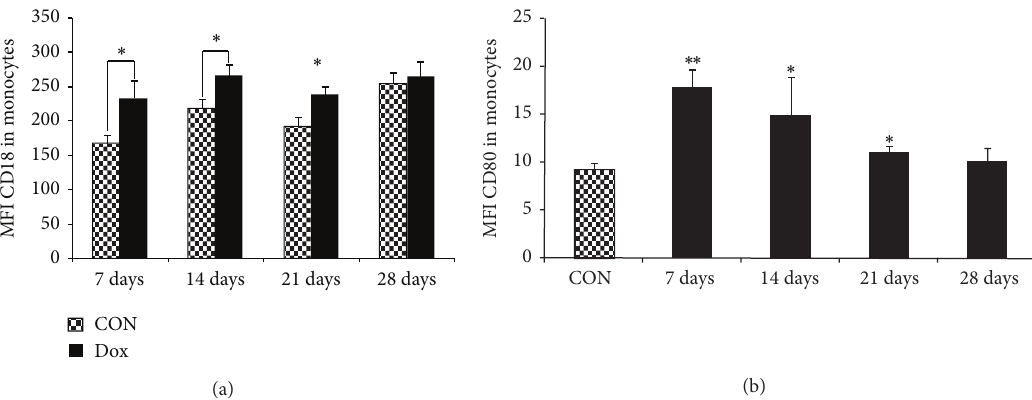
Figure 3: CD18 and CD80 expression in total monocytes from rats with nephrotic syndrome induced by doxorubicin and control animals in ex vivo condition. Blood leukocytesfrom rats ( 𝑛 = 32 ) that received a single dose of doxorubicin in tail vein (7.5mg/kg) and control rats ( 𝑛 = 32 ) that received PBS in the same condition were stained ex vivo for CD18 and CD80 expression. Data were collected using flow cytometry and analyzed using CellQuest software. Graphs (a) MFI of CD18 + monocytes and (b) MFI of CD80 + monocytes show expression of the given marker in lymphocytes. The data expressed as mean ± standard error for Dox group (black bars) and control group (grew bars). ∗ 𝑝 < 0.05 for the comparison between Dox and control group at the same time-point (Student’s 𝑡 -test).